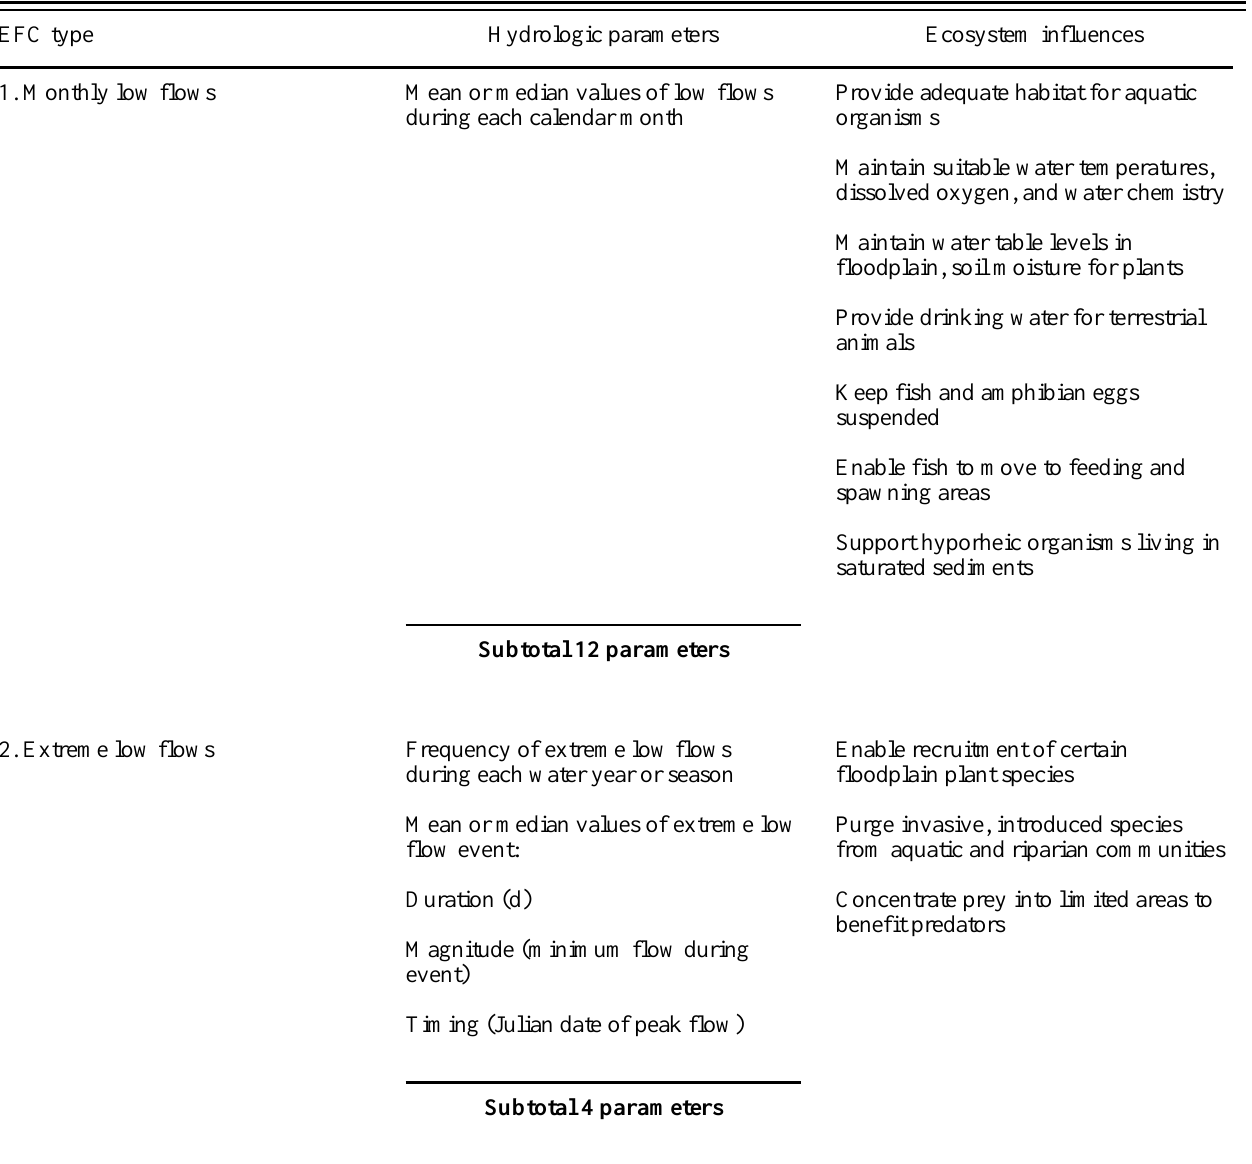
Table 1. Summary of the five environmental flow components (EFCs) used in the Indicators of Hydrologic Alteration software, and their ecosystem